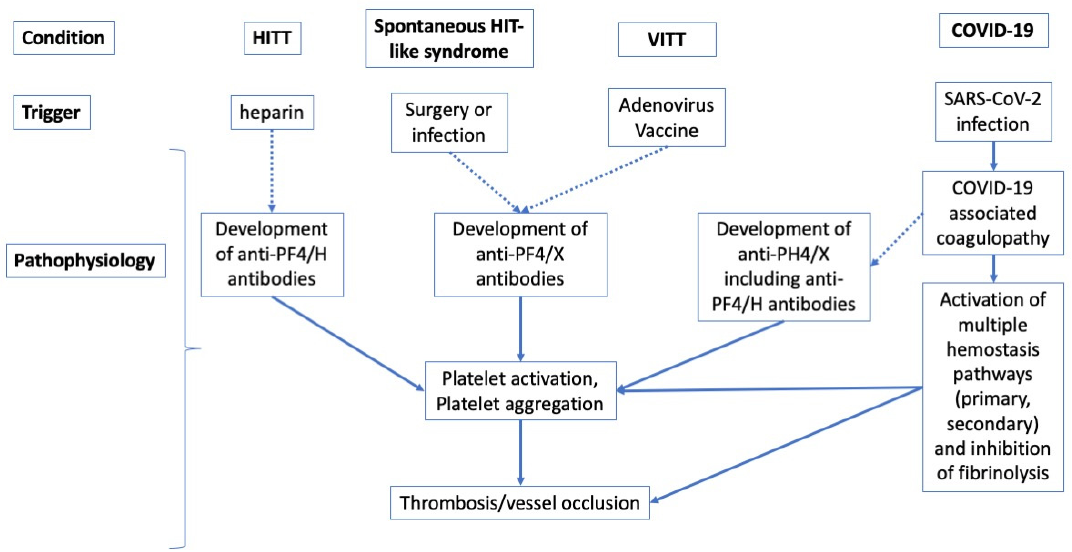
Figure 6. Navigating the differences and similarities of anti-PF4 antibody development in the different conditions considered in this review. ‘H’ in anti-PF4/H refers to heparin as the PF4 cofactor; ‘X’ in anti-PF4/X refers to a PF4 cofactor that may or may not be heparin. All conditions can lead to the development of anti-PF4 antibodies, which are anti-PF4/H in HITT and in some cases of COVID-19, and which are probably not anti-PF4/H in ‘spontaneous HIT-like syndrome’, in VITT and in a minority of cases of COVID-19. In COVID-19 patients, a generalized infection-associated coagulopathy may develop, in which only rarely will development of anti-PF4/X antibodies occur. Most cases of thrombosis in COVID-19 patients are thus unrelated to the development of anti-PF4/X antibodies.